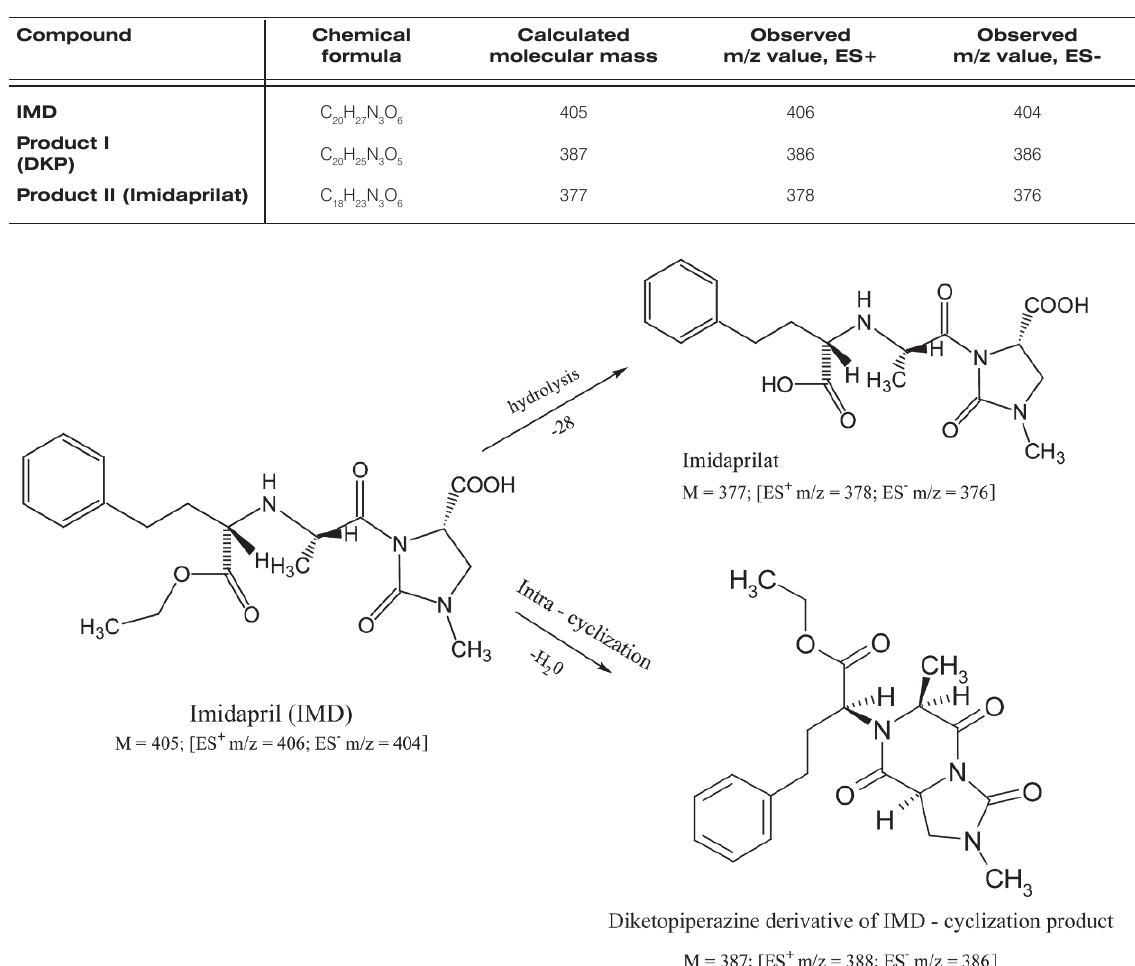
Figure 7. The proposed scheme for solid state IMD degradation under the conditions of T = 363 K, RH =